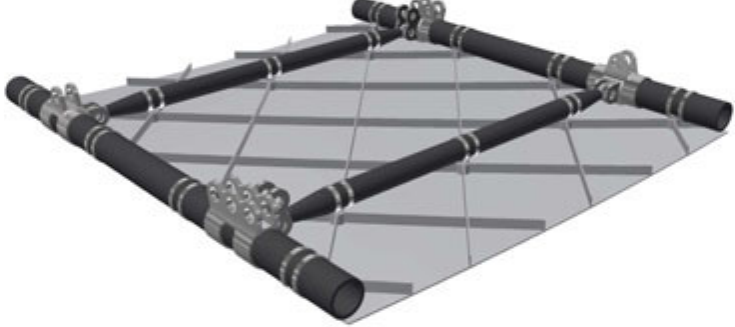
Figure 7. Frame composite structure, Adapt with permission from [50].